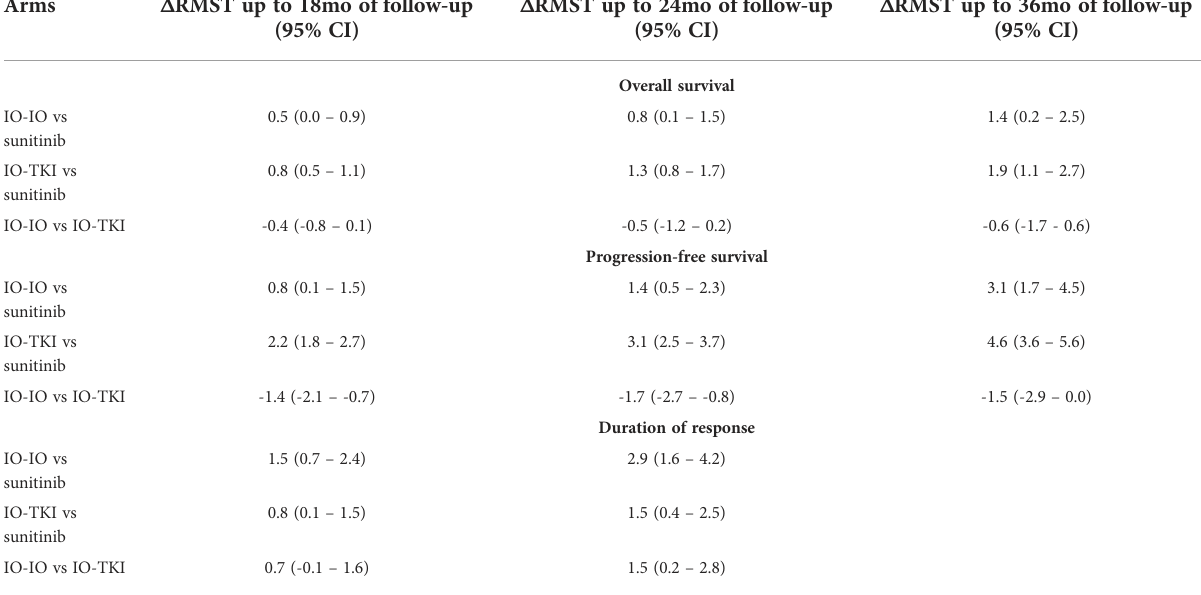
TABLE 3 Differences in restricted mean survival time (delta RMST) up to the time point of interest according to treatment arm. Arms D RMST up to 18mo of